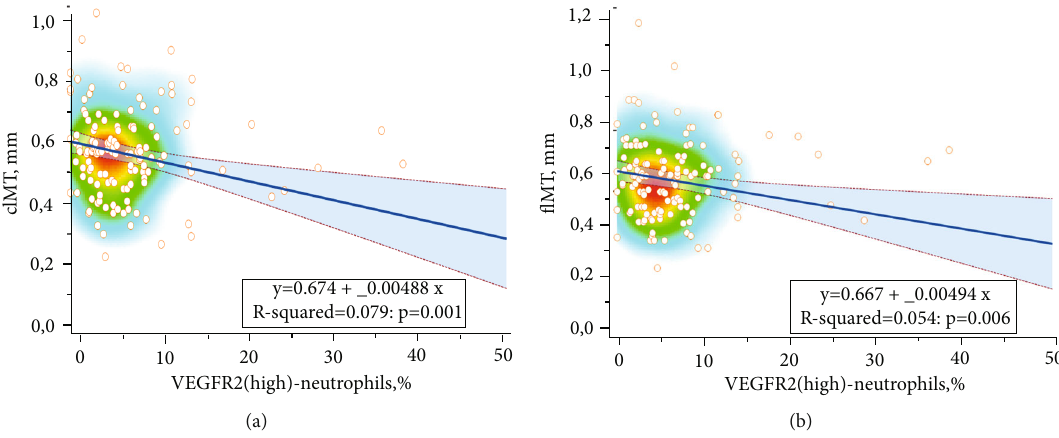
Figure 4: Relationships of VEGFR2 hi -neutrophils with carotid (a) and femoral IMT (b).